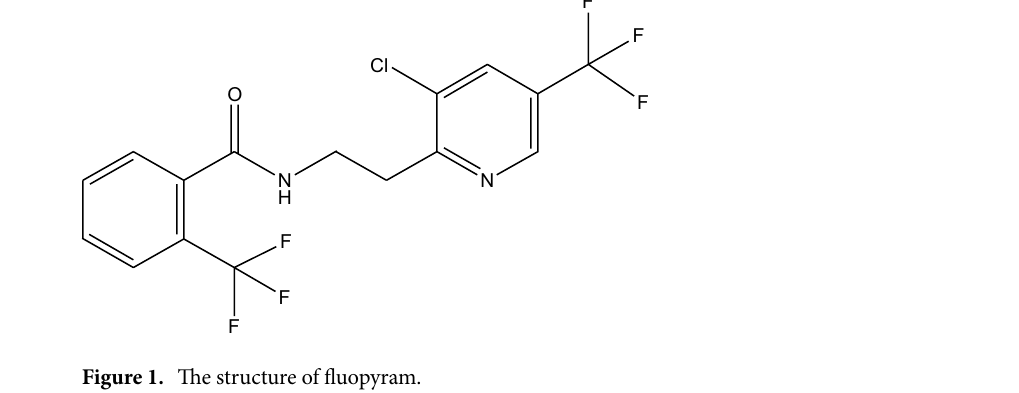
Figure 1. The structure of